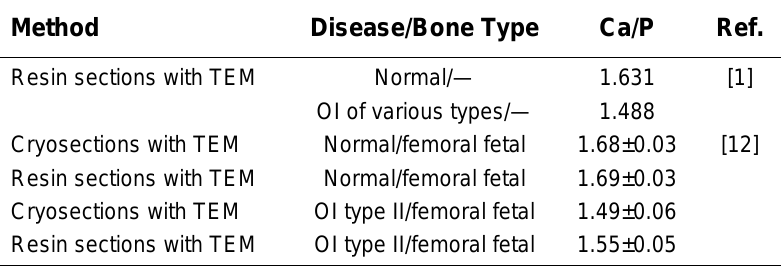
Results for the Ca/P Ratio on Human Bones Derived from the Literature with the Use of TEM on Cryosections or Resin Sections Method Disease/Bone Type Ca/P Ref. Resin sections with TEM Normal/— 1.631 [1] OI of various types/— 1.488 Cryosections with TEM Normal/femoral fetal 1.68±0.03 [12] Resin sections with TEM Normal/femoral fetal 1.69±0.03 Cryosections with TEM OI type II/femoral fetal 1.49±0.06 Resin sections with TEM OI type II/femoral fetal